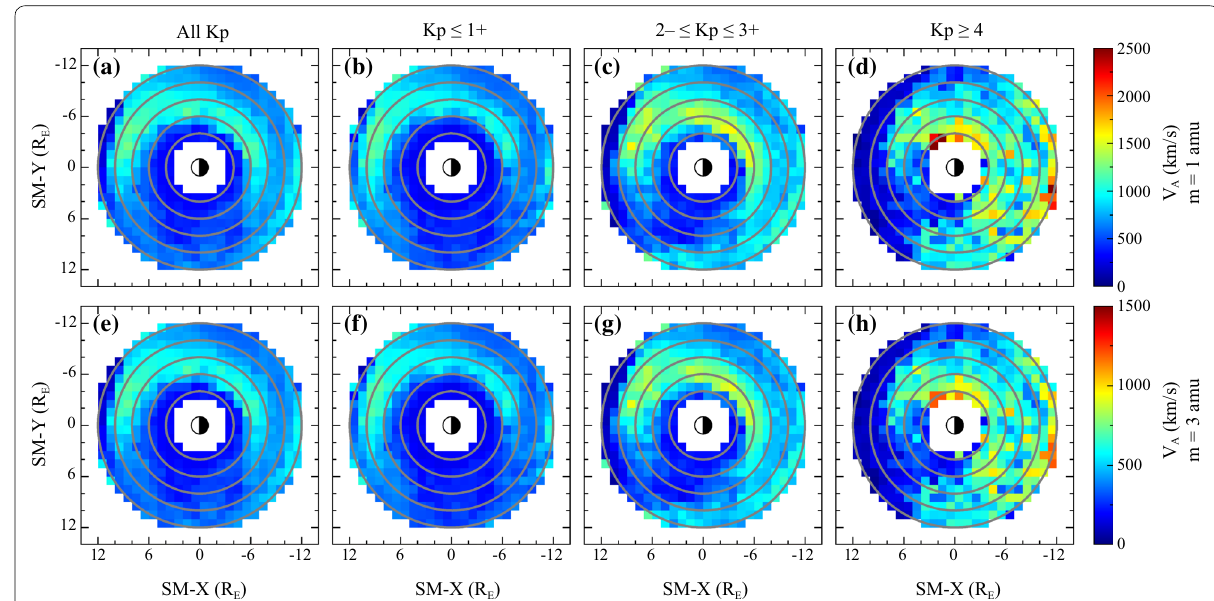
Fig. 4 The equatorial median Alfvén velocity calculated from the magnetic field intensity and electron density observed near the equator using Eq. (1) with m 1 amu ( a – d ) and m 3 amu ( e – h ) for four Kp levels = =